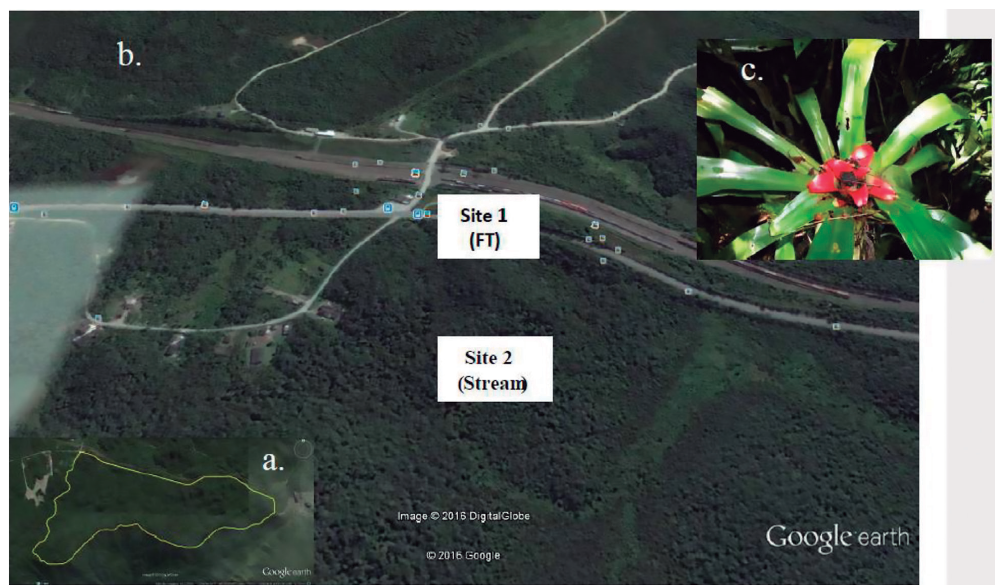
Figure 1. (a) Biological Reserve of Alto da Serra de Paranapiacaba (Santo André, São Paulo State, Brazil (Google Earth, 2014); (b) Localization of sampling sites (Image from Google Earth, 2014); (c) Bromeliad Nidularium longiflorum Ule (Photo: Neves,